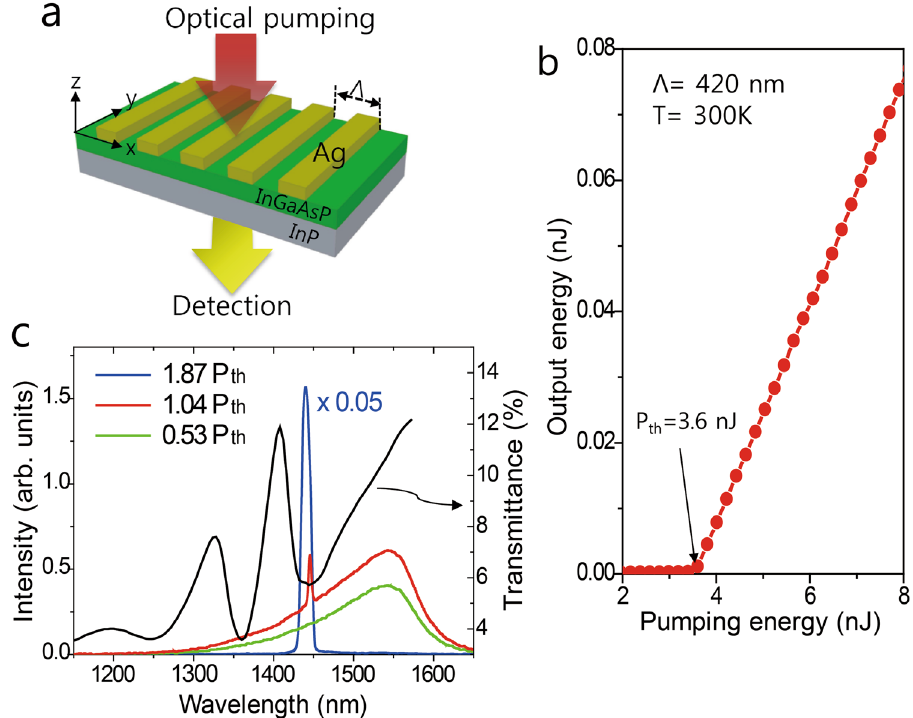
Figure 1. Demonstration of the SP lasing. ( a ) Schematic of the sample structure and experimental configuration. ( b ) Emission intensity as a function of the pump energy for a sample with Λ = 420 nm and FF = 0.6 at T = 300 K. ( c ) Emission spectrum measured for three different pump energies. For comparison, the linear transmission spectrum is plotted as a solid grey line. Lasing emission appears at the transmission dip caused by resonant SP